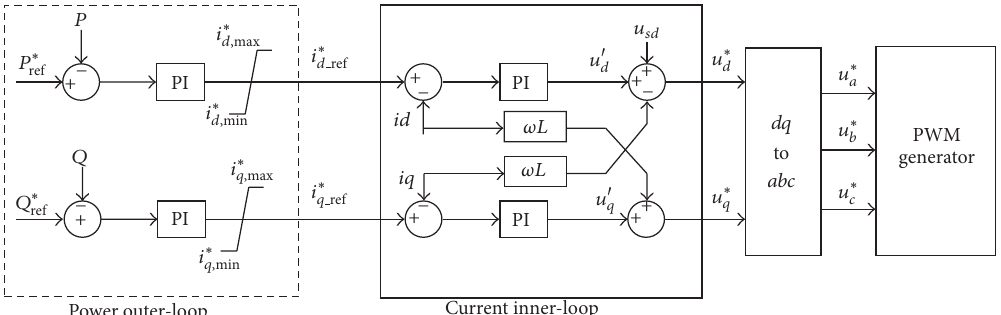
Figure 1: Schematic diagram of the PQ